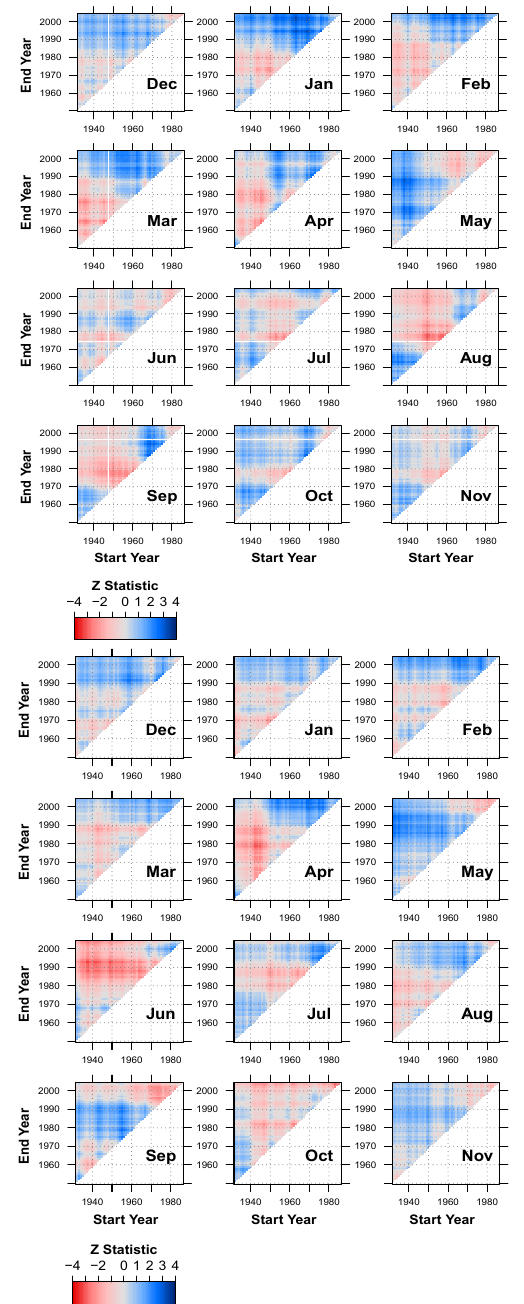
Fig. 6. Multi-temporal trend analysis for individual months for (top) Northern and (bottom) Northern Coastal regions. Explanation as for Fig. 5.